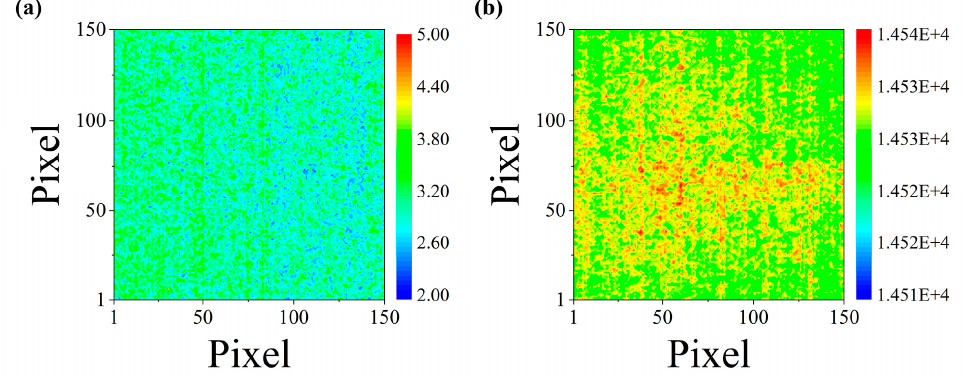
Figure 8. Reconstructed image data maps of ( a ) standard deviation and ( b ) average of each pixel for 100 frames of thermal image data.